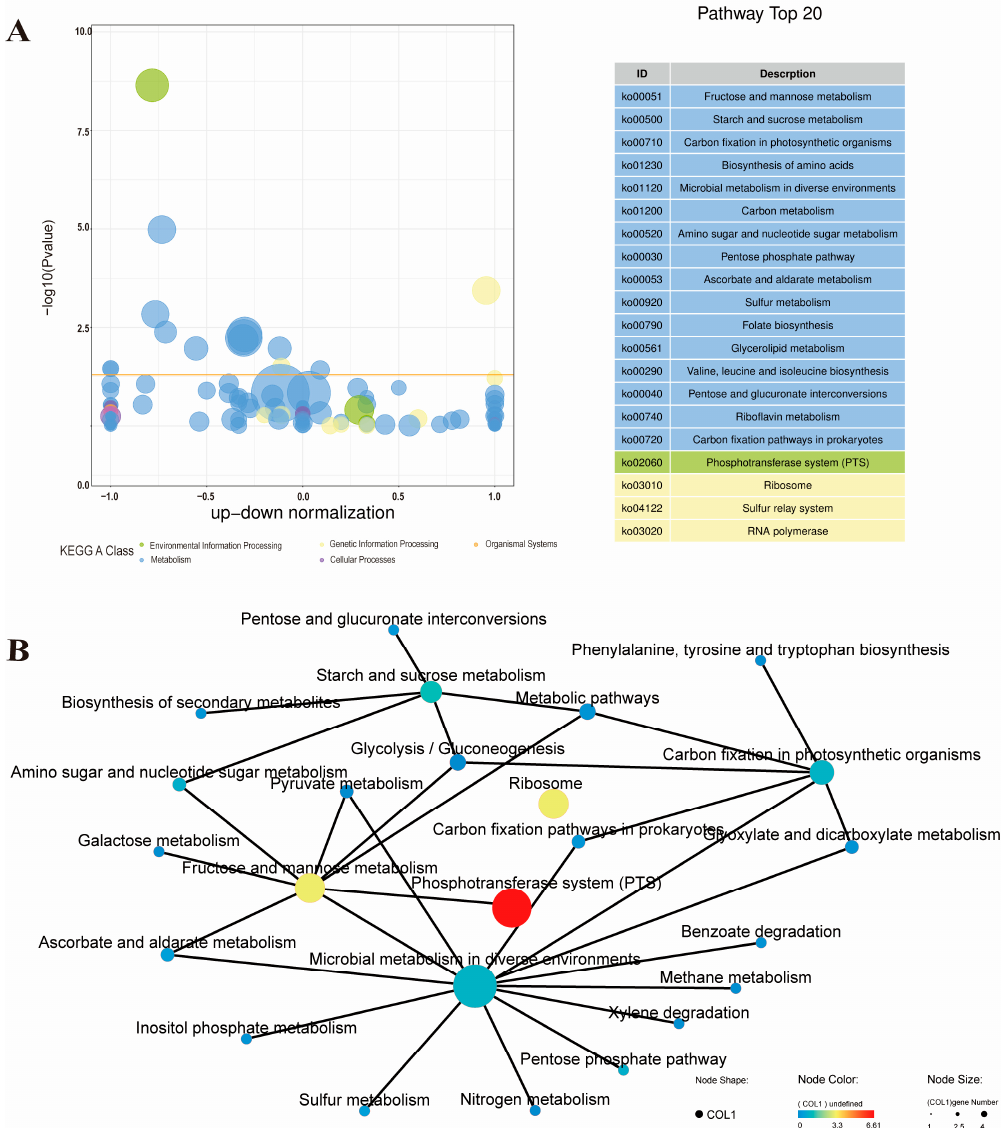
Figure 3. KEGG enrichment analysis of the ML group and the control. ( A ) Bubble plot of the top 20 KEGG enriched pathways. The horizontal axis of the bubble chart is the normalization coefficient of up and down; the vertical axis is − log10Pvalue. Different colors represent KEGG A classification of different pathways, and the orange threshold line is p -value = 0.05. Genes enriched by the current pathway are represented by the size of the bubble. The table on the right shows the 20 KEGG pathways with the smallest p -values. ( B ) Pathway networks enriched with KEGG annotations. The KEGG pathway is represented by nodes of different colors and sizes, with the size of the node representing the number of genes enriched in the pathway, and the gradient color of the node represents the p -value of the KEGG enrichment analysis; the solid line represents the connection between the pathway and the pathway or between the pathway and the gene. An isolated node in the graph indicates that the pathway is not directly related to other pathways in the